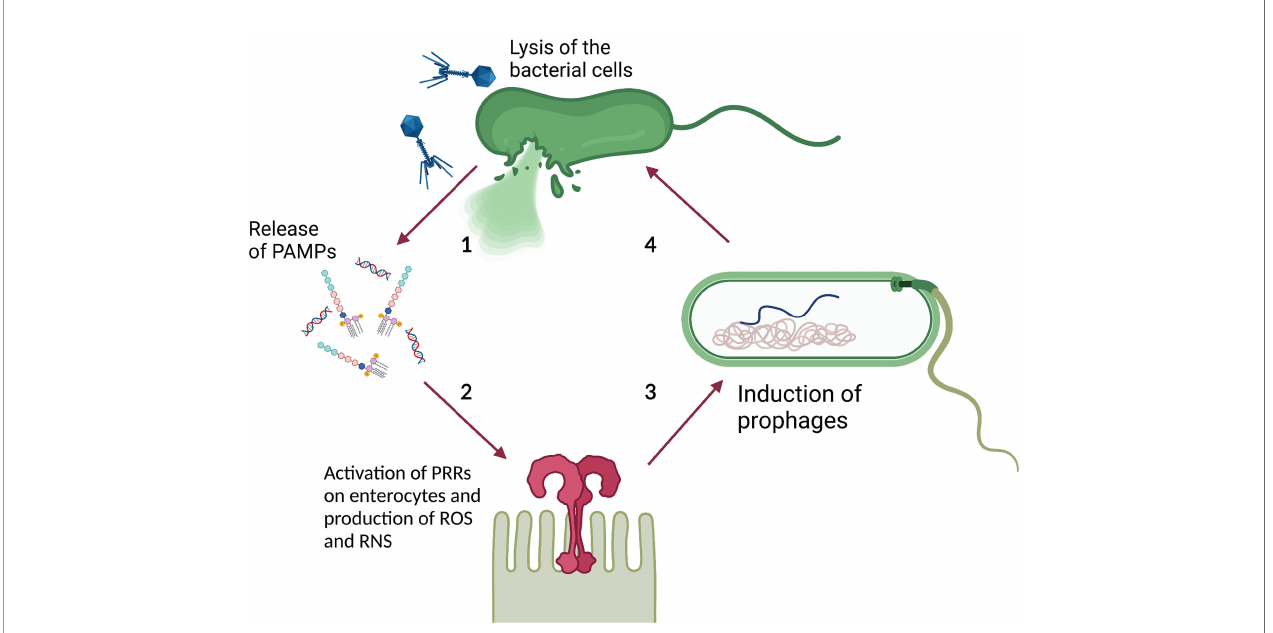
FIGURE 3 | Theoretical model of phage-PAMP-PRR mediated positive feedback loop for GIT in fl ammation. 1) Phage-mediated bacterial lysis causes the release of PAMPs, such as bacterial DNA and LPS. 2) PAMPs are recognized by PRRs, such as TLR, located on the surface of intestinal epithelial cells, leading to the production of ROS and RNS. 3) ROS and RNS stimulate prophage induction directly, by damaging bacterial DNA and activating the SOS response, or indirectly, by stimulating the in fl ammatory response. The in fl ammatory response increases the luminal oxidative stress causing damage to the DNA and activates the SOS response. 4) The induction of the dormant prophage causes the initiation of the phage lytic cycle resulting in the lysis of the bacterial cell. Image created with